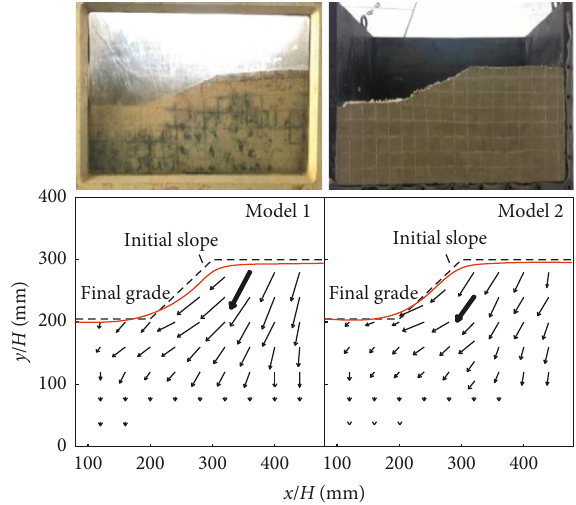
Figure 8: Slope failure and ultimate vector of